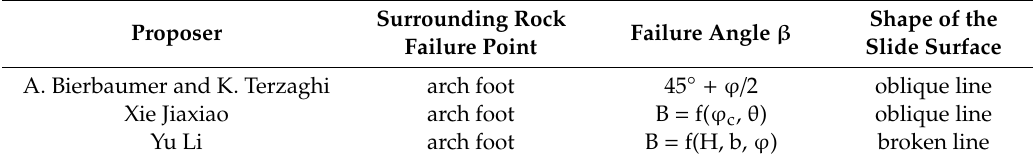
Table 1. Characteristics of the typical surrounding rock slide surface.